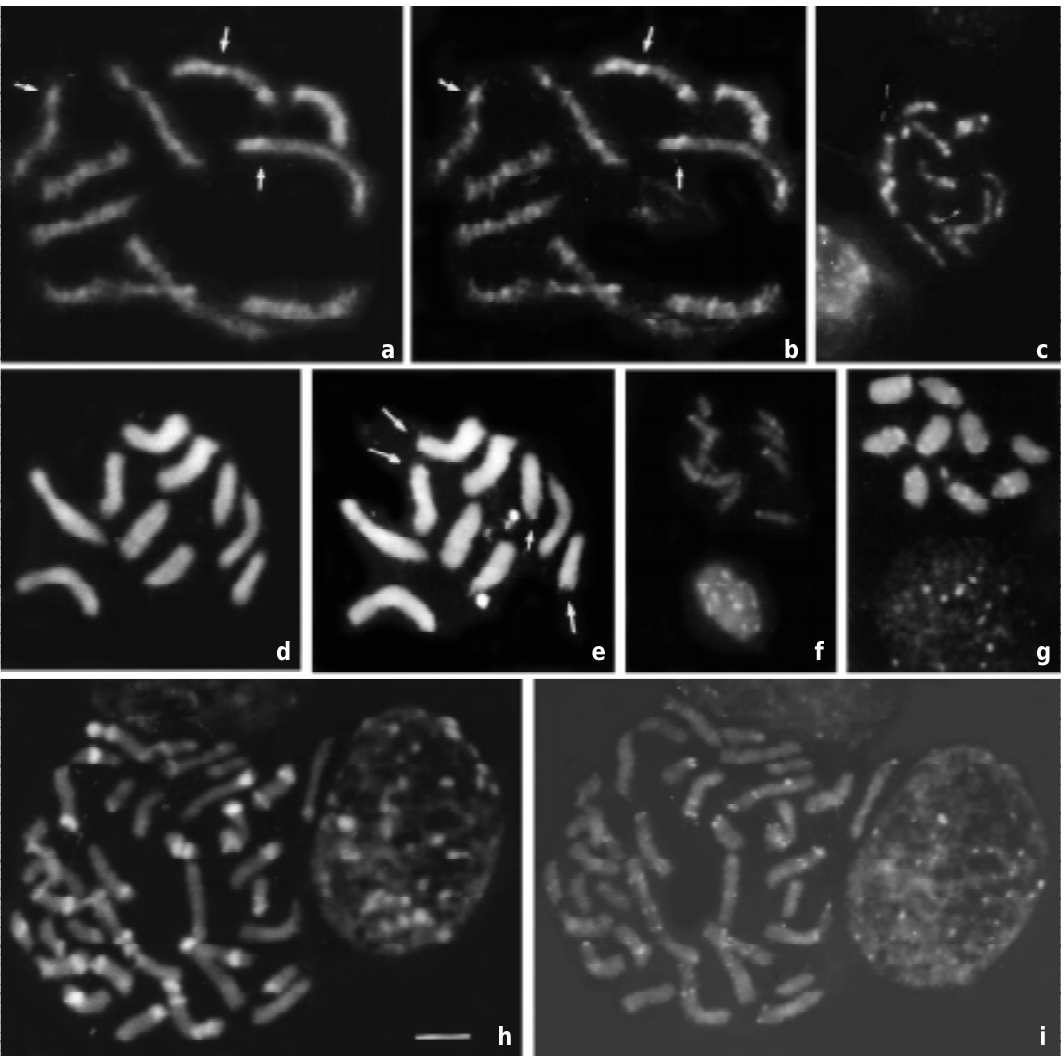
Figure 2 - CMA /DAPI banding in mitotic chromosomes of Rhynchospora. a and b ) Prometaphase in R. ciliata (2n =1 0) directly stained with DAPI 3 and CMA , respectively. Arrows indicate blocks DAPI 0 /CMA 3+ . c ) Chromosomes of R. ciliata stained with CMA 3 e ) Mitotic metaphase in R. pubera with 2n=10. Arrows show CMA 3+ blocks. f ) Mitotic chromosomes in R. riparia (2n = 10) stained with CMA C-banding procedure. g ) Mitotic chromosomes in R. barbata (2n = 10) stained with CMA with DAPI. i ) Mitotic chromosomes of R. globosa stained with CMA